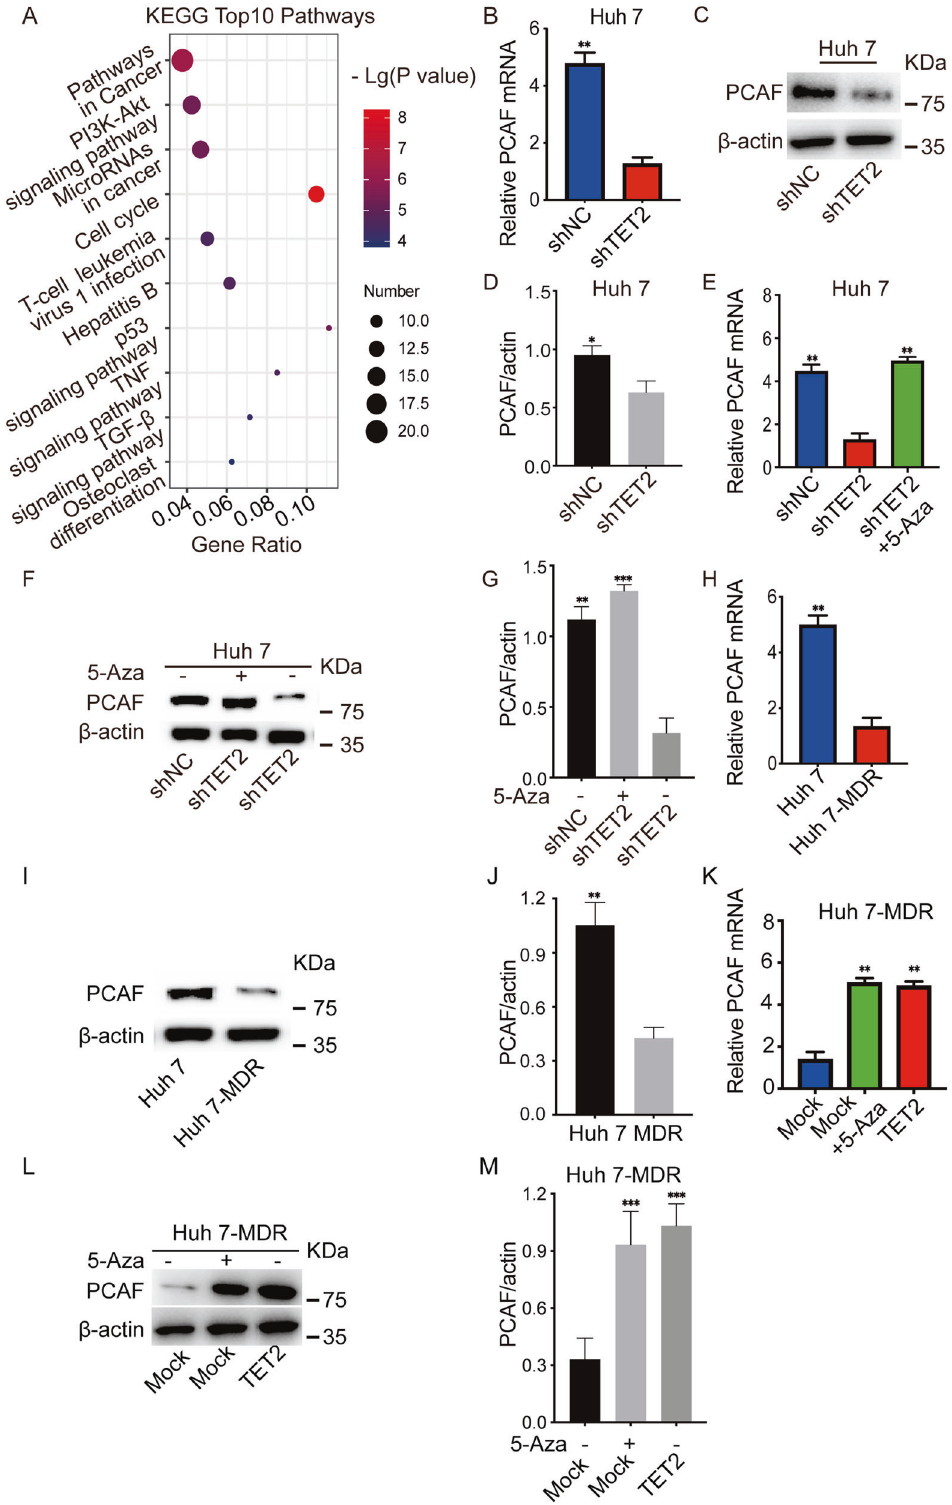
Fig. 3 TET2 regulates PCAF expression in HCC cells. A Top 10 signaling pathways between Huh7-shTET2 and Huh7-shNC cells determined by KEGG analysis. B PCAF mRNA expression in HCC Huh7-shNC and Huh7-shTET2 cells was determined by qRT-PCR analysis; n = 3; t test, ** P < 0.01. C , D Western blotting depicts the expression of PCAF in HCC Huh7-shNC and Huh7-shTET2 cells; n = 3; t test, ** P < 0.01. E PCAF mRNA expression in HCC Huh7-shTET2 cells treated with 5-Aza; n = 3; t test, ** P < 0.01. F , G The PCAF protein expression in HCC Huh 7 shTET2 cell lines treated with 5-Aza; n = 3; t test, ** P < 0.01; *** P < 0.001. H – J qRT-PCR analysis and Western blotting showed the PCAF expression in HCC Huh 7 and Huh 7-MDR cells; n = 3; t test, ** P < 0.01. K qRT-PCR analysis of PCAF mRNA expression in Huh 7-MDR-TET2 cells and Huh 7-MDR treated with 5-aza; n = 3; t test, ** P < 0.01. L , M Western blotting of PCAF protein expression in Huh 7-MDR-TET2 cells and Huh 7-MDR treated with 5-aza; n = 3; t test, *** P < 0.001. All data are presented as the mean ± SD, * P < 0.05; ** P < 0.01; *** P < 0.001. Cell Death and Disease (2023)